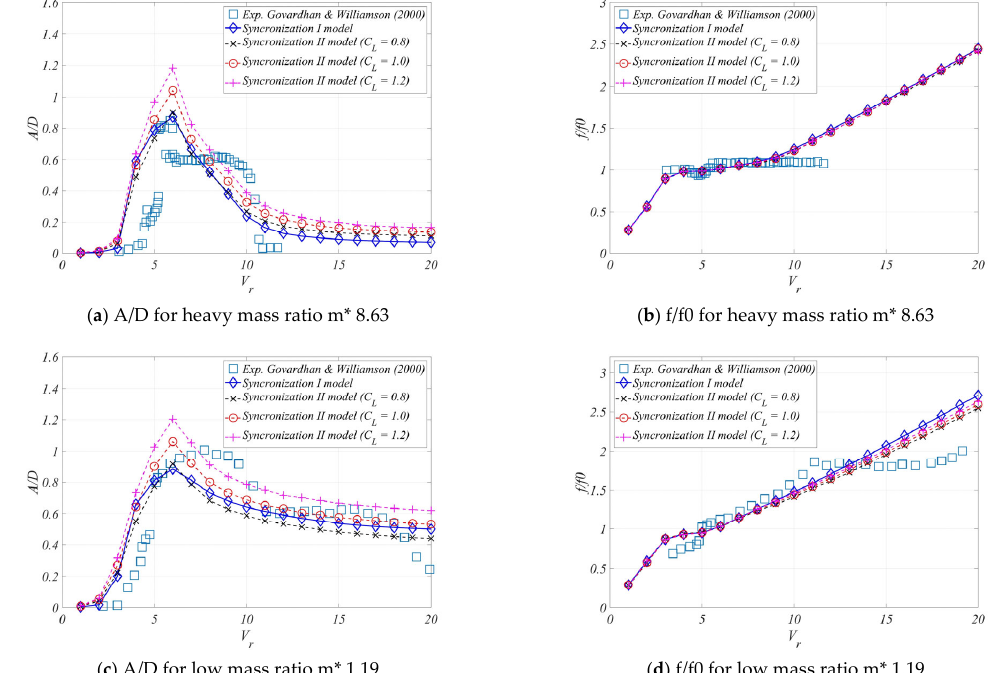
Figure 5. Results of free oscillations for the elastically supported circular cylinder.